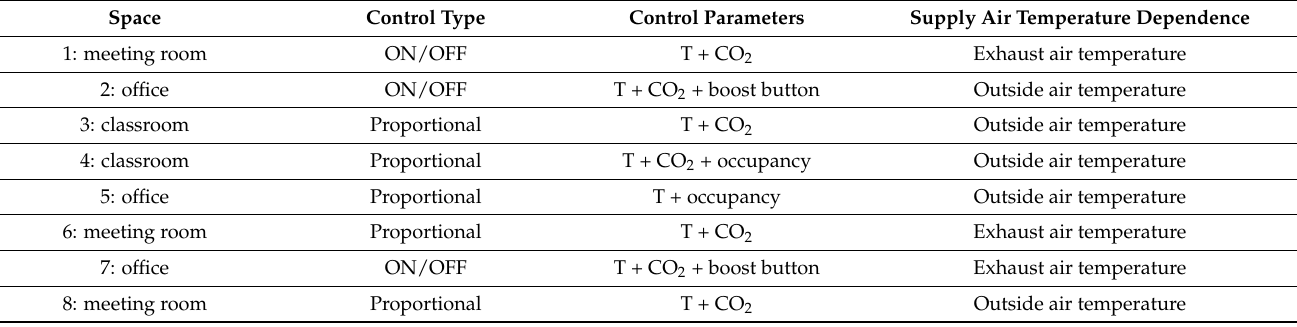
Table 2. The control methods of the studied